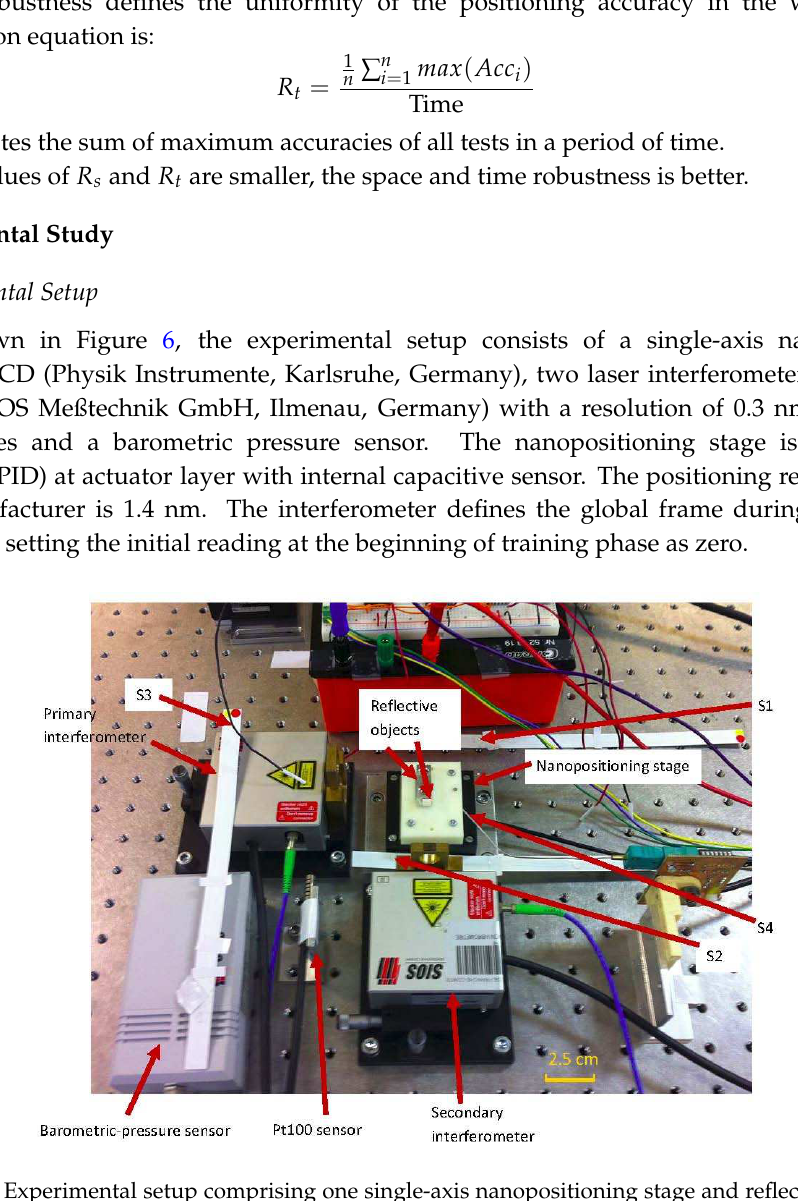
Figure 6. Experimental setup comprising one single-axis nanopositioning stage and reflective object, two interferometers with affiliated pressure/temperature sensors, four temperature